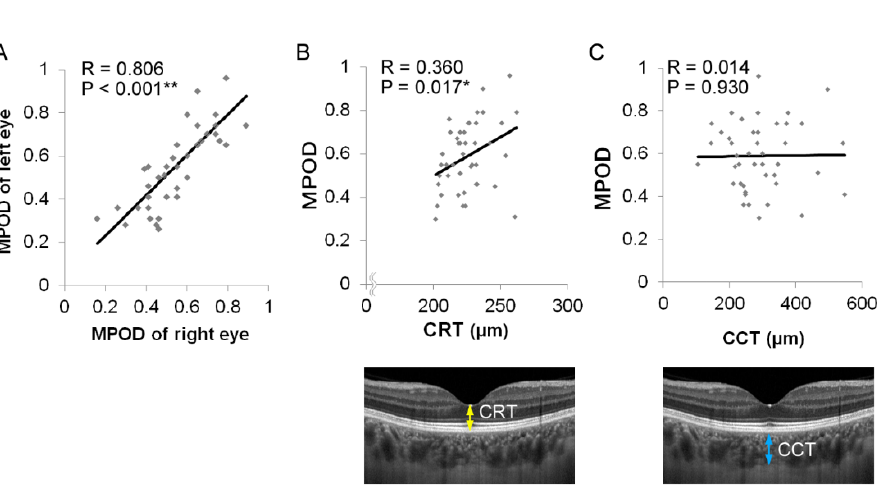
Figure 1. Correlation between the central retinal thickness (CRT), central choroidal thickness (CCT), and macular pigment optical density (MPOD). (A) Correlation of MPOD between the right and left eyes of the individuals was confirmed. (B) A positive correlation was seen between CRT and MPOD. The arrow in the OCT image indicates CRT. (C) No significant correlation was seen between CCT and MPOD. The arrow in the OCT image indicates CCT. ** P < 0.01, * P < 0.05.